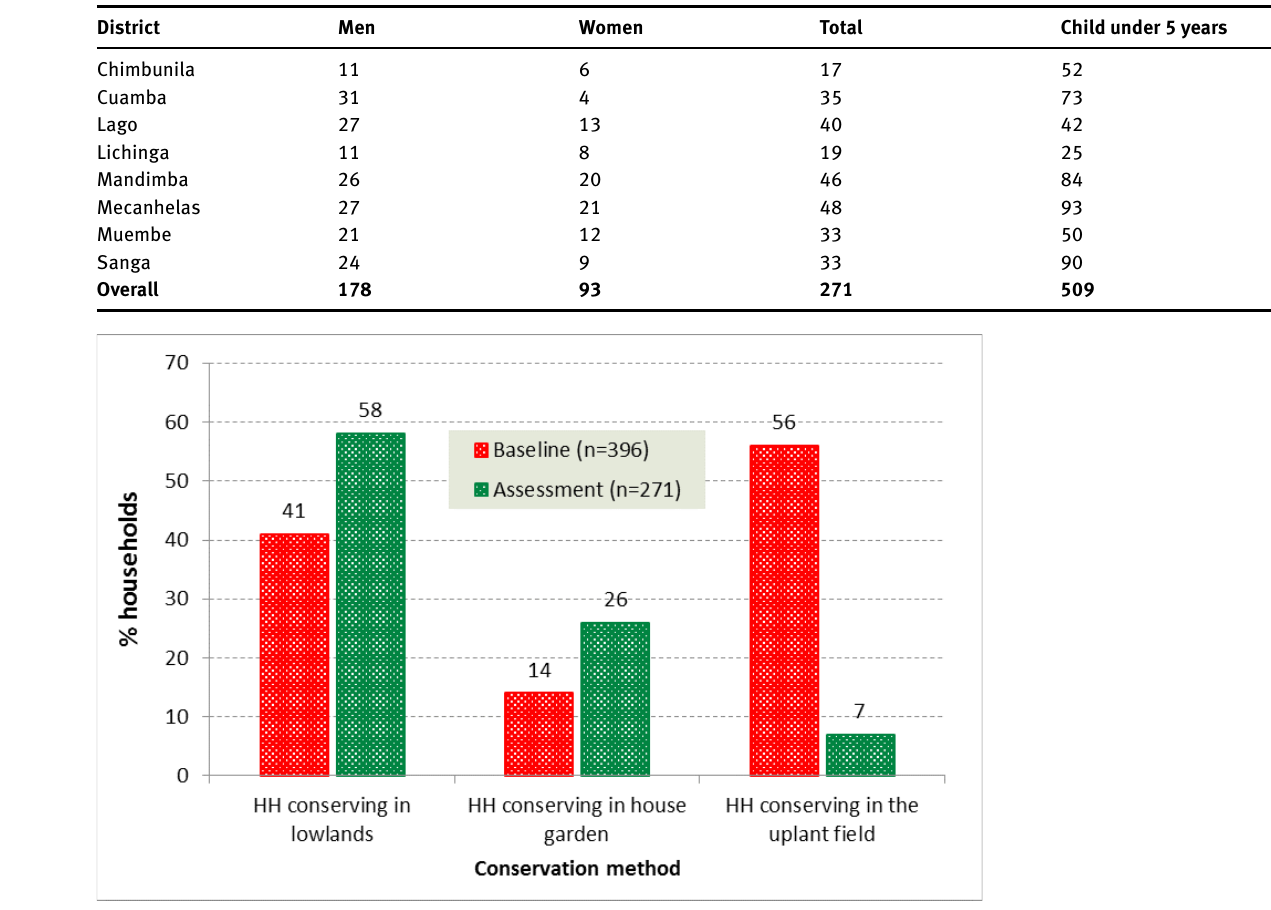
Figure 3: Changes in vine conservation